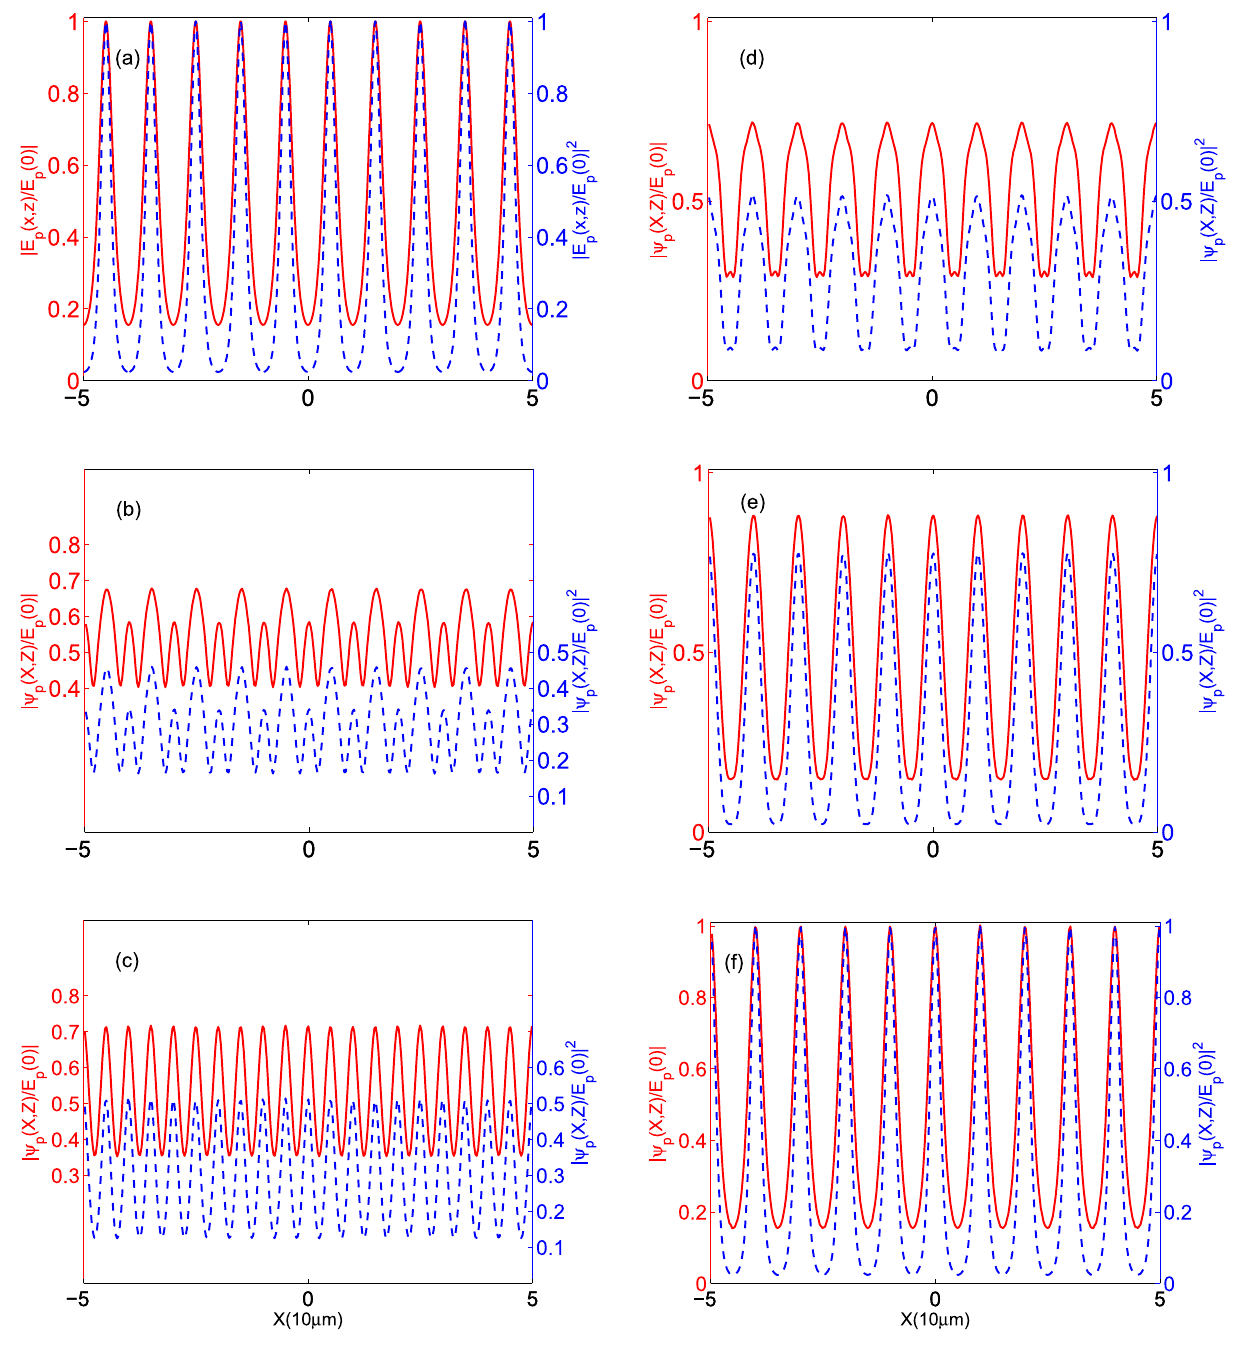
4 , ( d ) Z = 3 Z 8 , ( e ) Z = 9 Z 20 , and ( f ) Z = Z 2 . Solid (dashed) curves with the left (right) T / T / T / T / vertical axis demonstrate the amplitude (intensity) of the field in all panels. The selected set of parameters are � c 0 = 0.5 Ŵ , L = 2.5 µ m, and T e = Ŵ . The other used parameters are the same as in Fig.